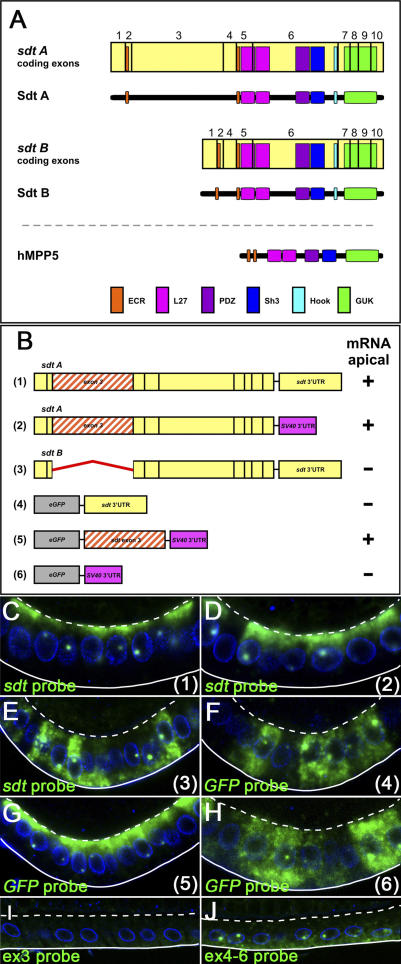
Exon 3 Contains the sdt Apical Localization Signal(A) Diagram showing the relationship between the exon structure of two sdt mRNA isoforms and the protein domains they encode. Exon 3, which is deleted from the sdt B isoform, encodes no conserved functional domains. The stretch of amino acids encoded by exon 3 is not conserved in other Sdt homologs such as human MPP5.(B) Diagram summarizing the experimental results from the six UAS-transgenes used to map the sdt apical localization signal to exon 3. All transgenes were expressed under the control of the GR1 FC driver. (C–H) Fluorescent in situ hybridization (green), using probes against either sdt (C–E) or GFP (F–H) reveals the localization of transgenic mRNAs in the FCs at stages 8–9.(C) Transcripts from a transgene representing the sdt A isoform localize apically.(D) sdt A transcripts continue to localize apically without the sdt 3′UTR.(E) Transcripts from a transgene representing the sdt B isoform, which lacks exon 3, are distributed uniformly in the cytoplasm.(F) Adding the sdt 3′UTR to an eGFP transgene is insufficient to target these transcripts apically.(G) Adding sdt exon 3 to an eGFP transgene is sufficient to send the mRNA apical.(H) Neither the SV40 3′UTR nor the eGFP coding region can direct a transcript to the apical cytoplasm.(I and J) Fluorescent in situ hybridization (green) reveals the localization of endogenous mRNAs at stage 10. A probe specific to sdt exons 4–6 stains the unlocalized transcripts at stage 10 (J), while a probe specific to exon 3 does not (I).(C–J) The nuclear envelope is marked with WGA (blue). The apical surface is denoted with a dashed line and the basal surface with a solid line. (A) has been adapted with permission from a figure by S. Berger and E. Knust (unpublished).